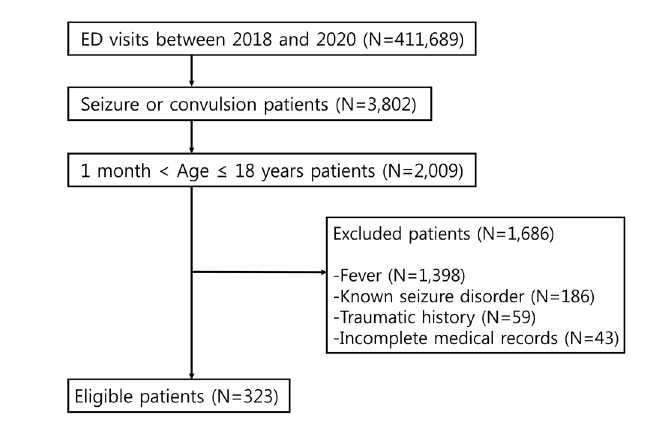
Figure 1. Flow chart of patient selection for study of neuroimaging in first afebrile pediatric seizure.